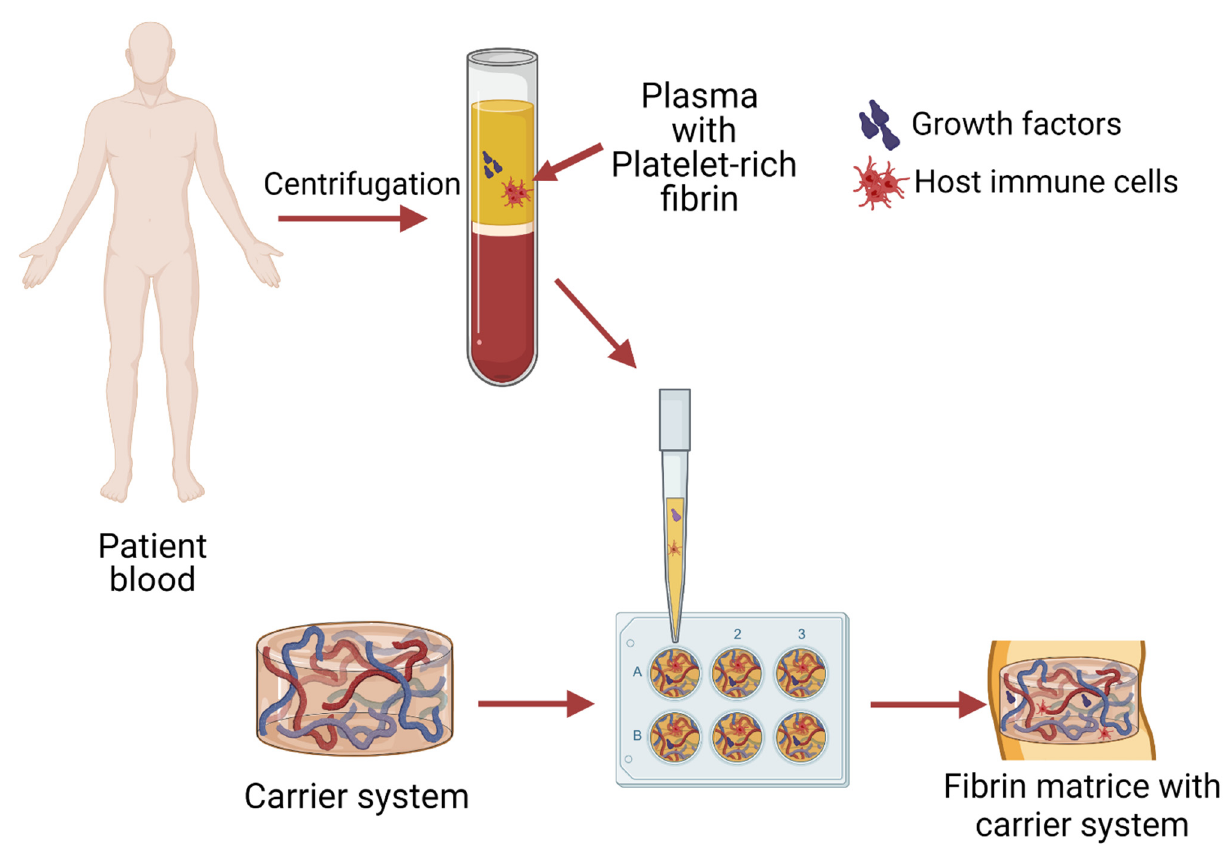
Figure 3. Principle scheme of platelet-rich fibrin as a carrier system preparation. Human blood is centrifuged by separating the PRF with a plasma layer. Obtained PRF is added it to pre-prepared carrier systems to obtain a PRF/drug carrier matrices. Figure created with Biorender.com.